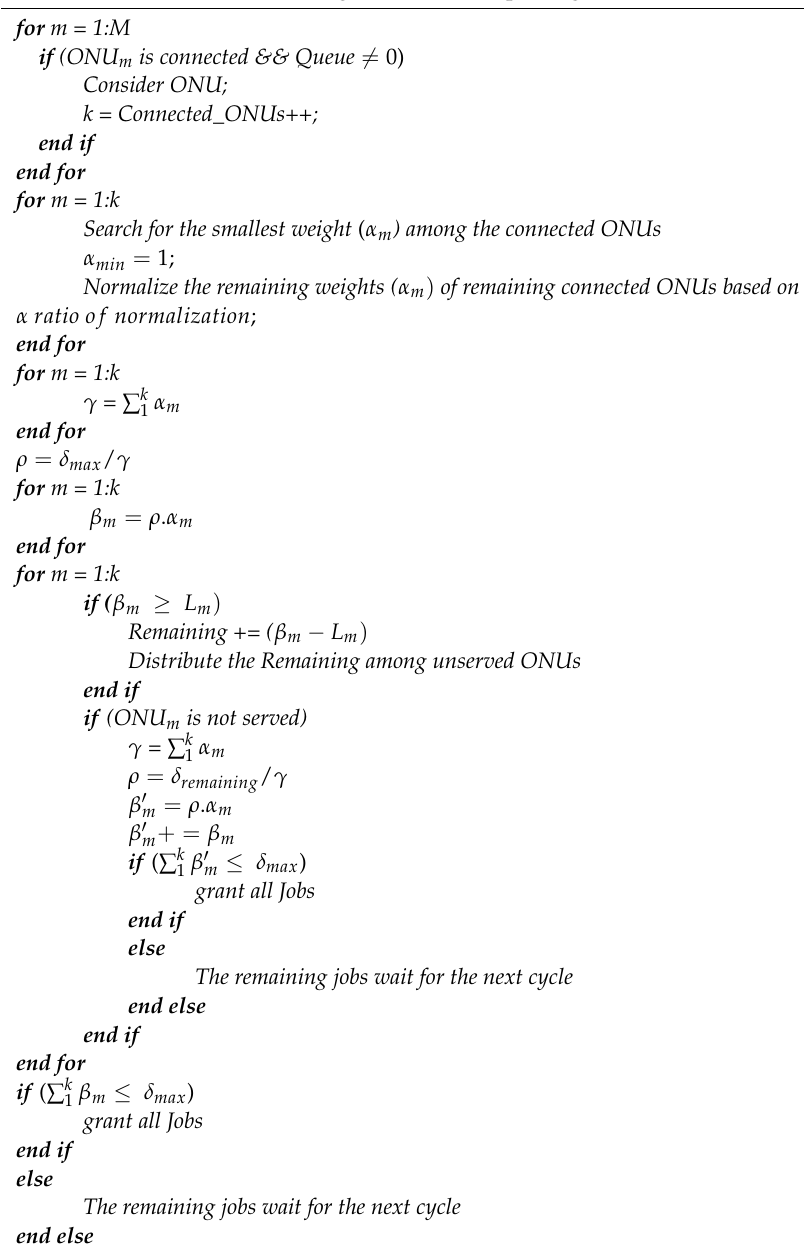
Algorithm 2. Pseudocode for WFQ executed at the OLT for each cycle i